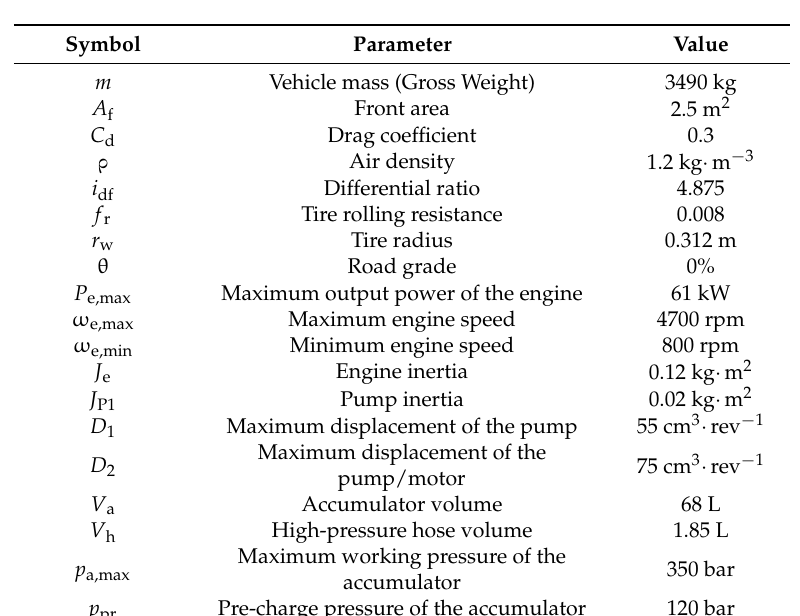
Figure 2. The Simulink Model of SHHV. Table 1. System